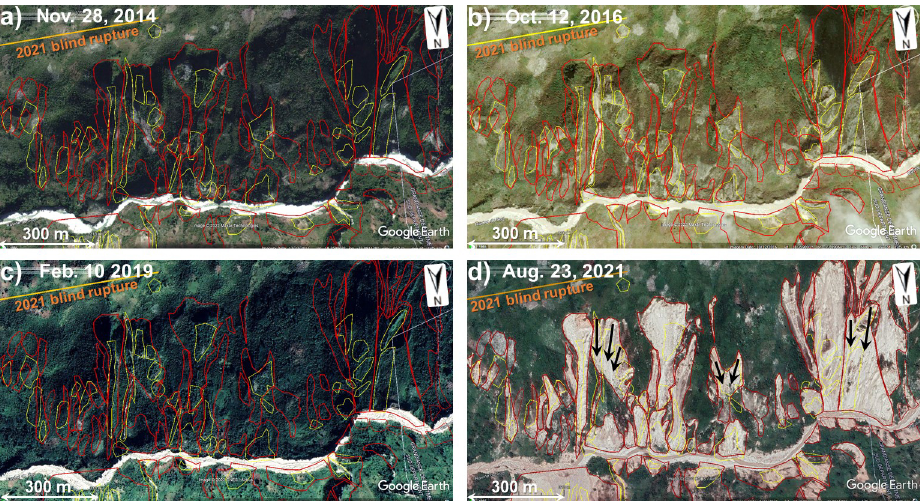
Figure 3. Evolution of landslides within the zone marked in Fig. 2: November 2014 (a) ; October 2016, after Hurricane Matthew ( b ); a view of the area in February 2019 (c) ; and a view of the area in August 2021 (d) , about 10d after the earthquake. Landslides that occurred during or directly after the Hurricane Matthew event are outlined in yellow, and those that were triggered by the 14 August 2021 earthquake are shown by dark-red polygons; see also black arrows marking the coalescence of landslides with distinct sources (only for three examples shown). All views © Google Earth